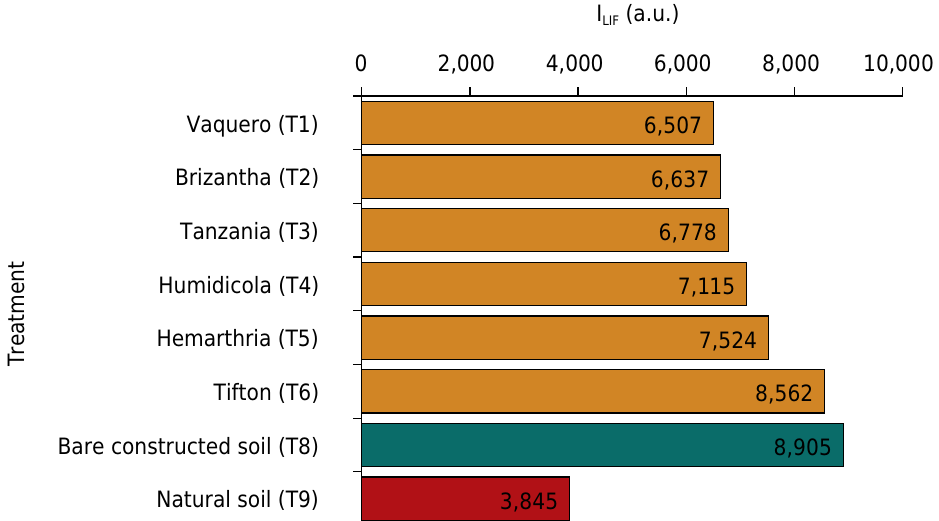
Figure 2. Laser-induced Fluorescence index (I LIF ) of organic matter in the 0.00-0.03 m layer of a constructed soil covered with different grass species, a bare constructed soil and a natural soil (unmined, with native